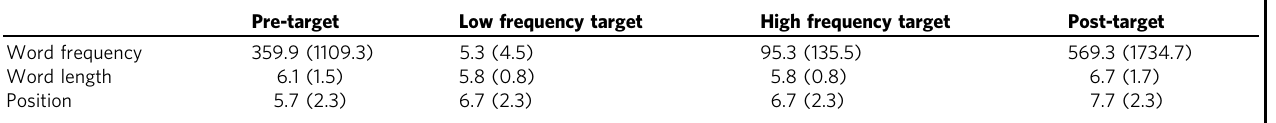
Table 1 Characteristics of words used in the current